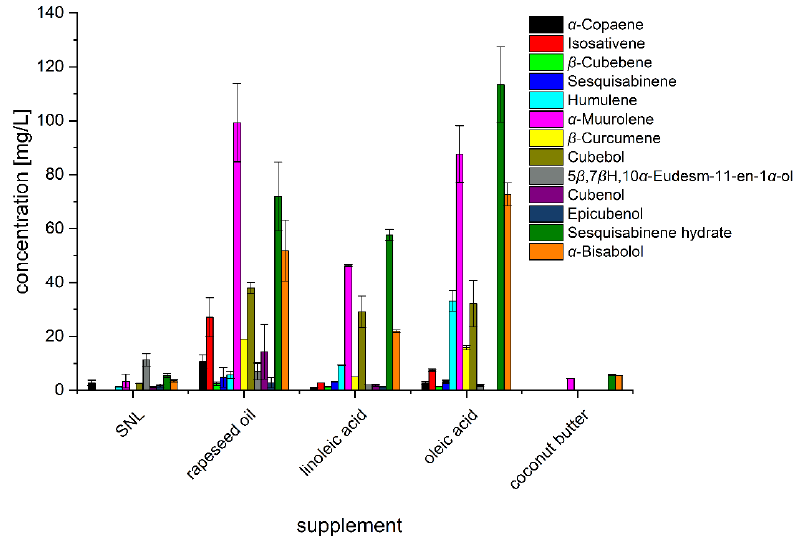
Figure 5. Sesquiterpenoid production of Cerrena unicolor supplemented with 2% lipidic additives after eleven days of cultivation. Products were analyzed using TDS-GC-MS after the liquid–liquid extraction of culture supernatant.